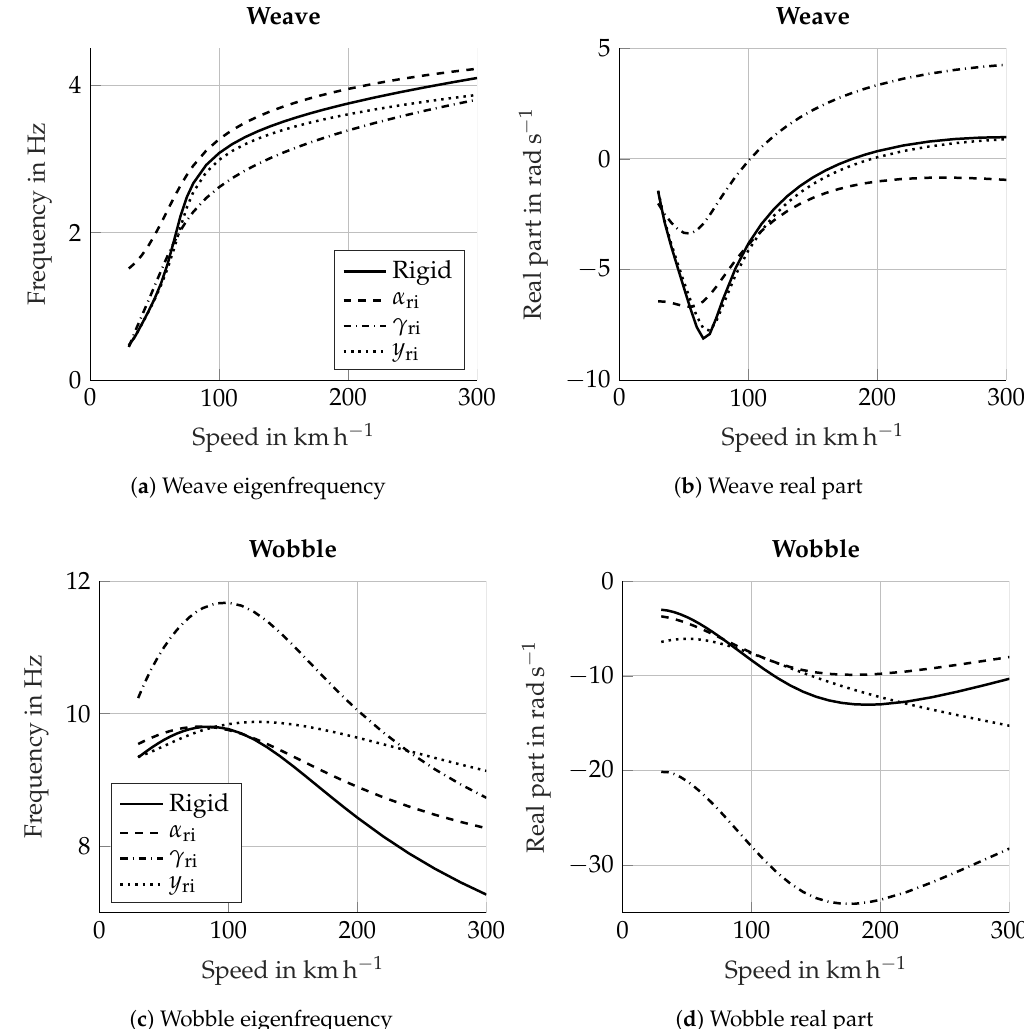
Figure 15. The rffects of the single rider’s DoF on the weave and wobble